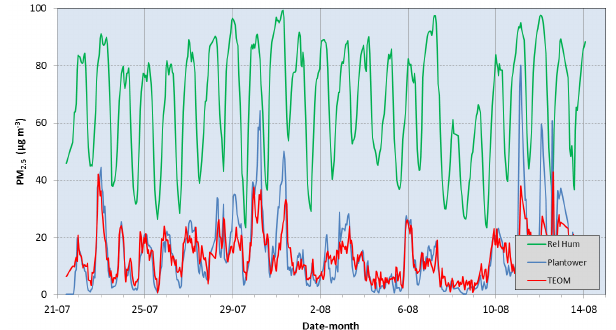
Figure 3. Time series of the PM 2 . 5 concentrations reported by the PMS1003 and the standard TEOM, together with the relative hu- midity, during the entire duration of the